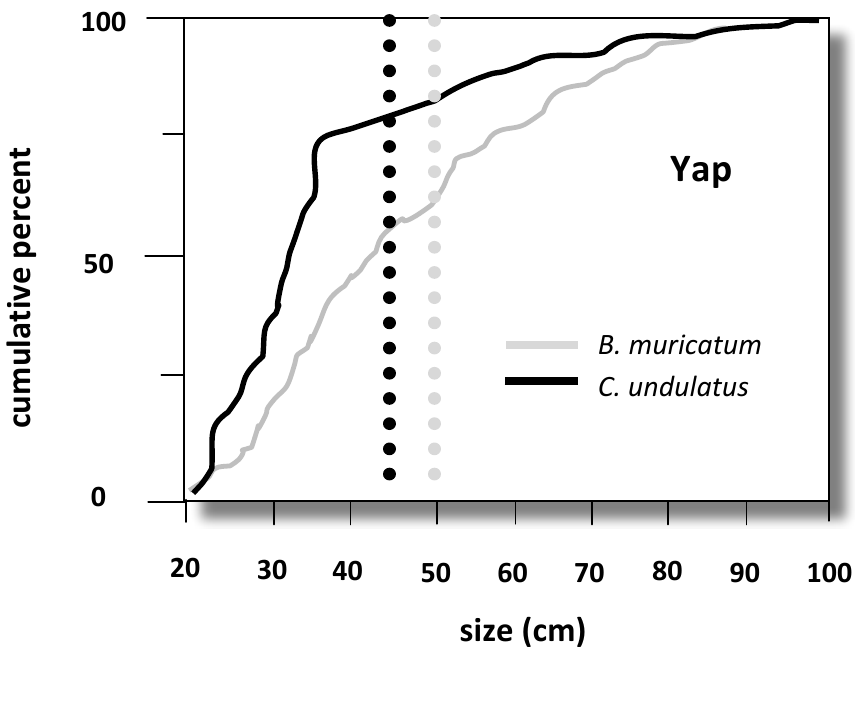
Figure 4. Cumulative size-at-capture graph for bumphead parrotfish ( B. muricatum ) and humphead wrasse ( C. undulatus ) in Yap, redrawn from [256]. The vertical dotted lines are the L50 for each species, the median size of first reproduction. Both species were harvested below their L50, C. undulatus more than B. muricatum